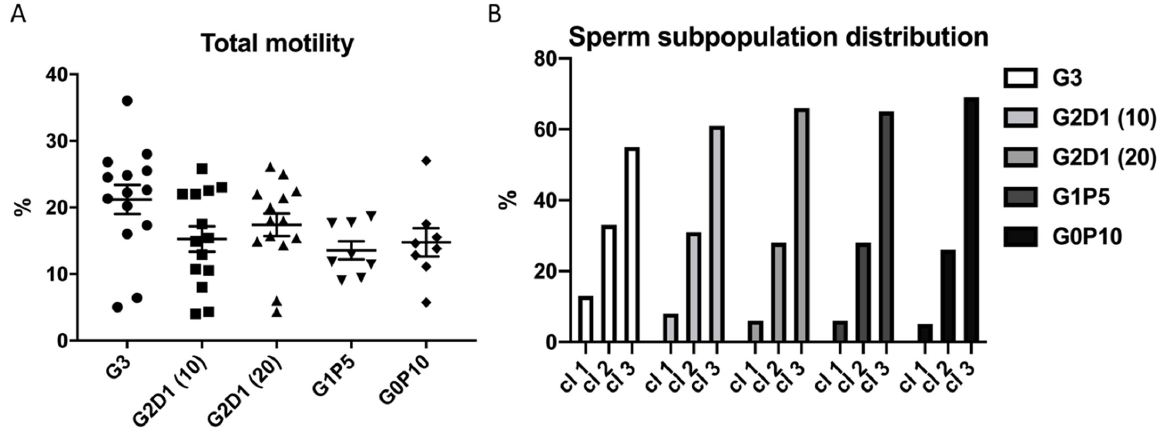
Figure 3. Boar sperm motility analysis after cryopreservation in modified extender. ( A ) Total sperm motility and ( B ) distribution of sperm subpopulations after cryopreservation in extender modified by dextran and pentaisomaltose as G3 (control with 3% of glycerol), G2D1 (10) (2% glycerol, 1% dextran 10 kDa), G2D1 (20) (2% glycerol, 1% dextran 20 kDa), G1P5 (1% glycerol, 5% pentaisomaltose), and G0P10 (0% glycerol, 10% pentaisomaltose) for cl1 (fast sperm subpopulation), cl2 (medium sperm subpopulation), and cl3 (slow sperm subpopulation). Semen from four boars were collected, and each individual was analyzed in three replicates. Statistical significance ( p < 0.05) was not found.